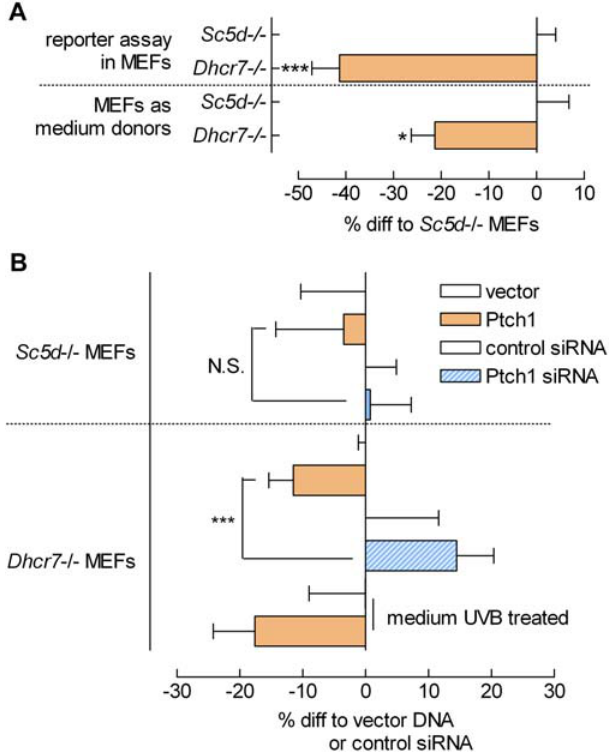
Figure 5. Differentially Modulated Ptch1 Action in Dhcr7 –/– and Sc5d –/–